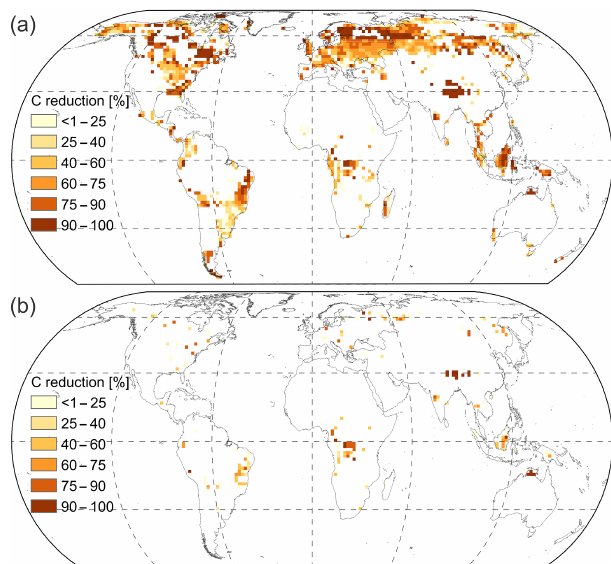
Figure 6. Reduction of forest C sequestration due to geogenic P limitation. C reduction estimated from stoichiometric C : P ratios for the N-limited AR scenario assuming P concentrations within fo- liar and wood material corresponding to mean values (Table 1). In Fig. 2b we present the C sequestration potential if geogenic P sup- ply is not limiting biomass growth. (a) C reduction based on P gaps in Fig. 5a, obtained for geogenic P supply scenario one (geogenic P from weathering plus atmospheric P deposition as source of P). (b) C reduction based on P gaps of Fig. 5c, obtained for geogenic P supply scenario two (geogenic P from soil inorganic labile P and organic P pools plus atmospheric P deposition and P from weather- ing as source of P). For resulting global C reduction check Table 3. © ESRI.